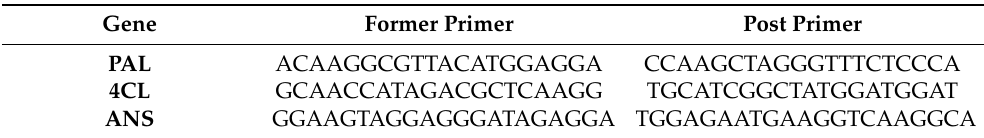
Table 7. Genes and primers